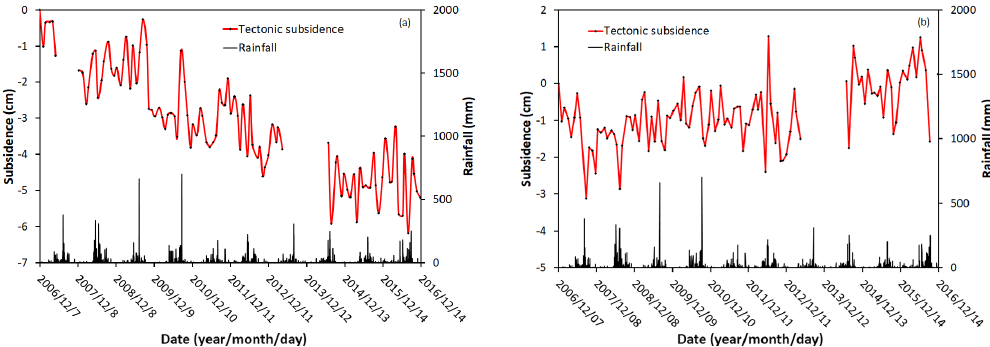
DXi2 FL1 0.62 DX1 0.01